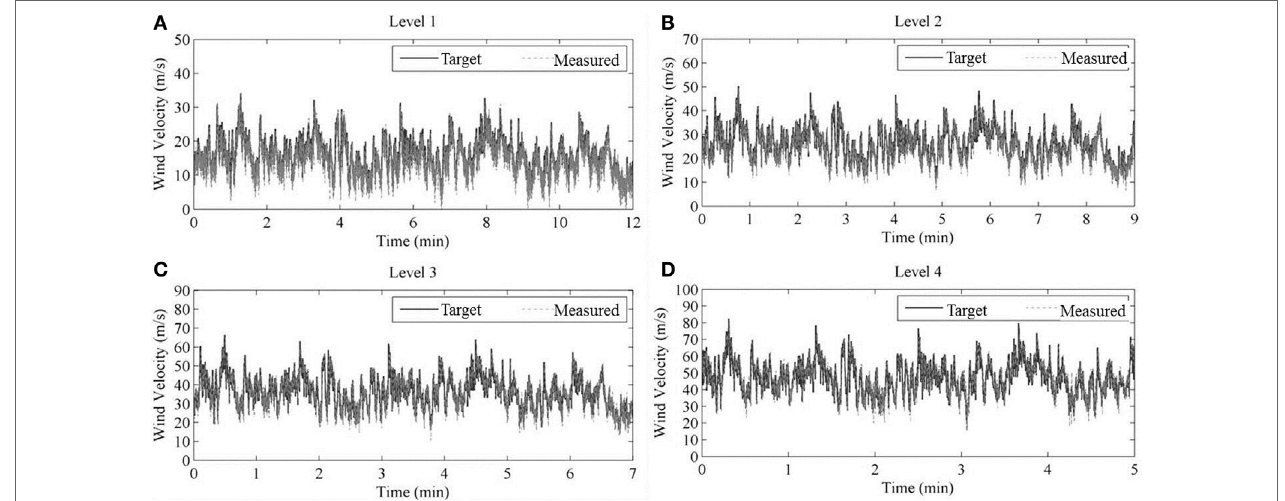
TaBle 2 | statistics of the input and measured wind velocity at four levels. level 1 (m/s) level 2 (m/s) level 3 (m/s) level 4 (m/s) Target Measured Target Measured Target Measured Target Measured